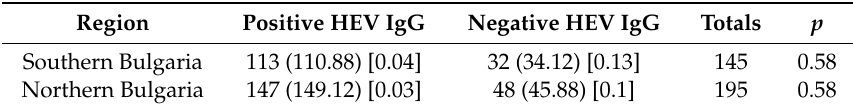
Table 3. The regional factor a ff ecting HEV seroprevalence. N denotes the number of animals, p — p -value and in the brackets [the chi-square statistic for each